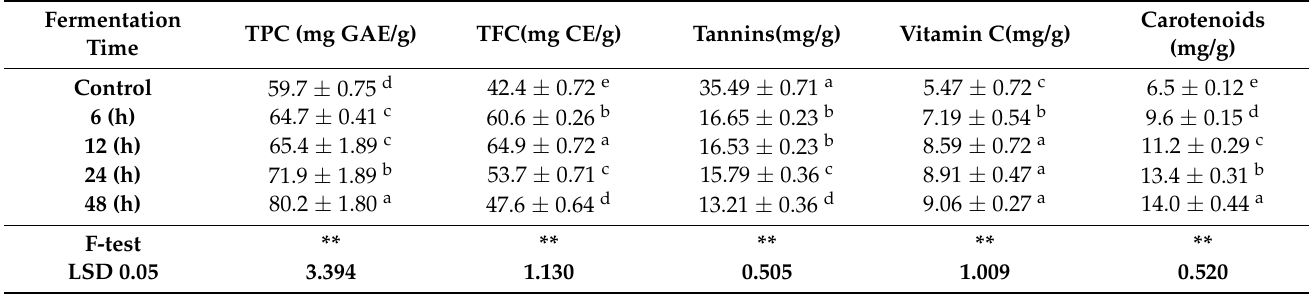
Table 3. Effect of natural fermentation on the phytochemical content of “Nabag” ( Ziziphus spina-christi L.) seeds.